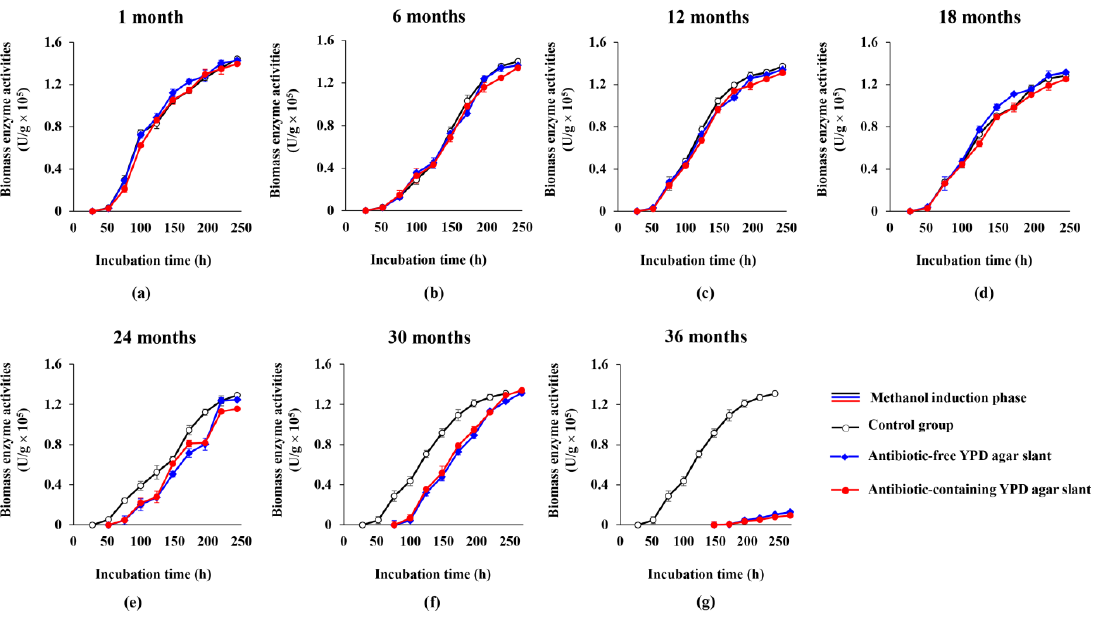
Figure 3. Curves of biomass enzyme activities of the GS115-3.5K-P1-2 preserved in the YPD agar slants at 4 ◦ C for different months ( a – g ). Black hollow lines: the control group; Blue solid lines: the antibiotic-free YPD agar slant; Red solid lines: the antibiotic-containing YPD agar slant.